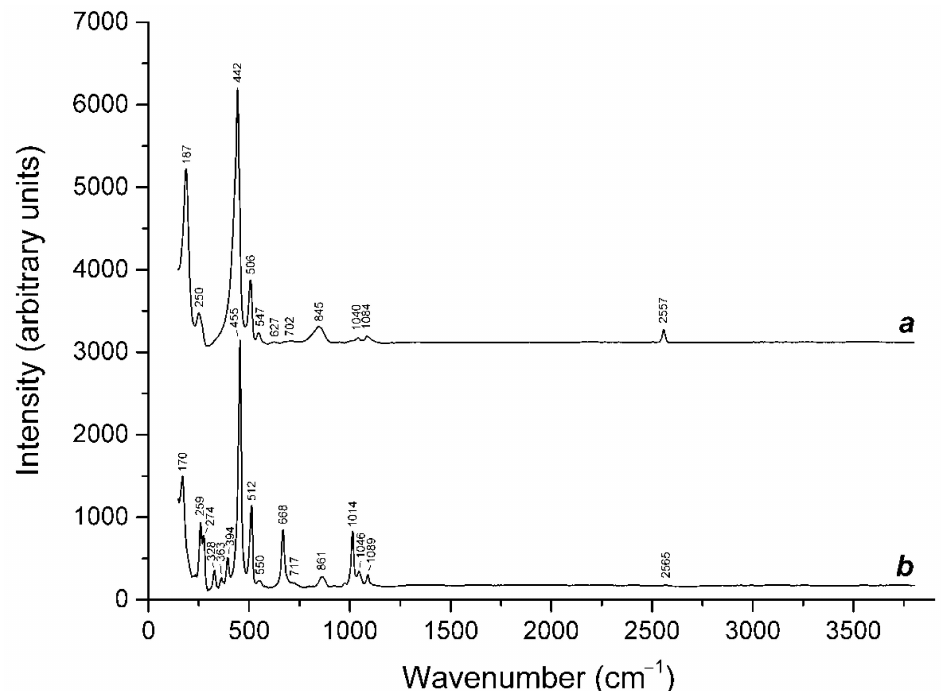
Figure 12. Raman spectra of ( a ) yellow bystrite (Sample 9) and ( b ) orange–yellow bystrite (Sample 10). The bands in the range of 845–858 cm − 1 correspond to the first overtone of the bands in the range of 442–455 cm − 1 . All other bands in the Raman spectrum of sulfhydrylbystrite correspond to the stretching and bending vibrations of the framework. The very weak bands at 975 and 2565 cm − 1 in the Raman spectrum of orange–yellow bystrite (Sample 10) indicate the presence of trace amounts of the SO 42 − and HS − anions,